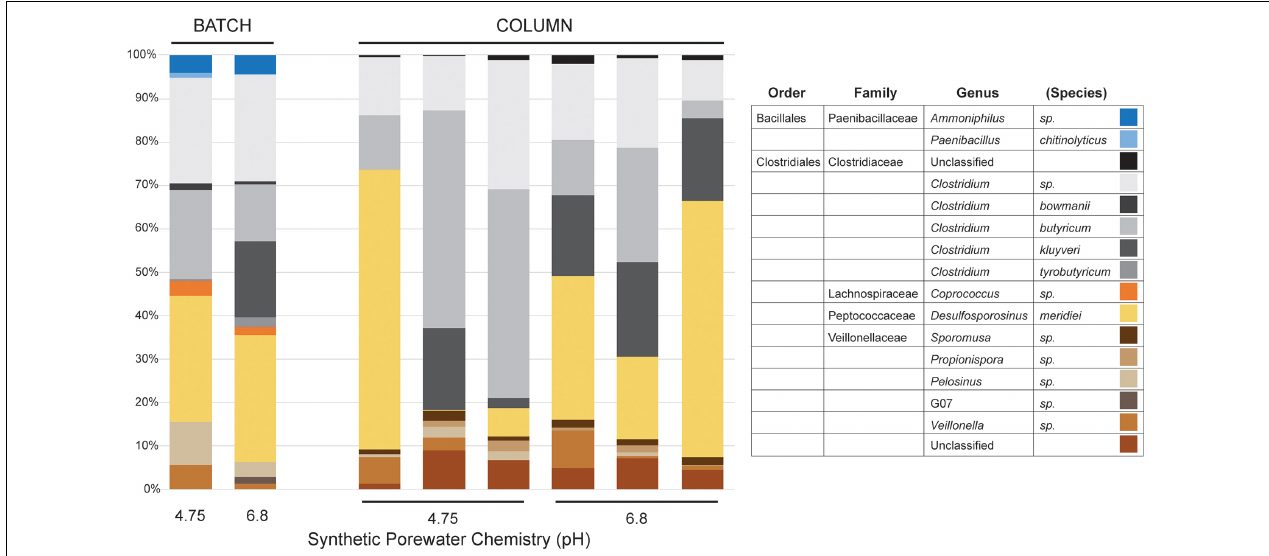
FIGURE 3 | Illumina sequencing results of genus-level community diversity within the Firmicutes from the batch and column cultures. Only the SPW/lactate results are shown. The distribution of genera in the batch cultures (BATCH) and individual columns (COLUMN) are shown, along with the basal pH of the SPW at day 0 is shown. Given the myriad of Family- and Genera-level distributions within the Firmicutes, the Order/Family/Genus classification is provided for each identified